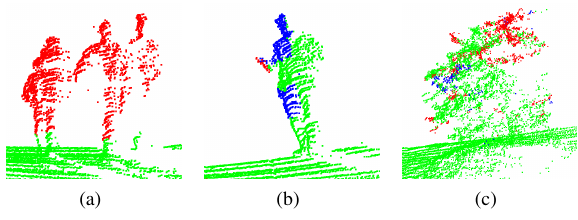
Figure 7. Examples for moving objects and vegetation. Moving object (red), static structure (green) and undetermined (blue). (a) Discretization error. (b) Labeling error due to partial movement. (c) Tree with leaf